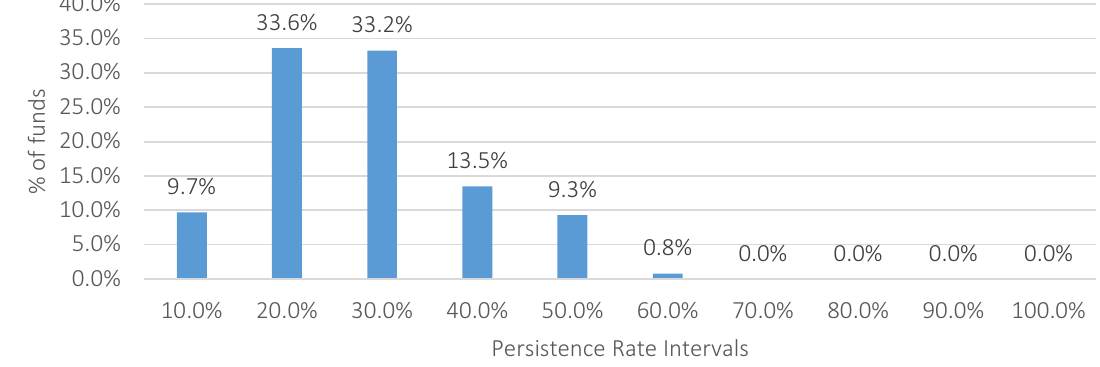
Figure 2. Histogram of persistence rate in pension funds